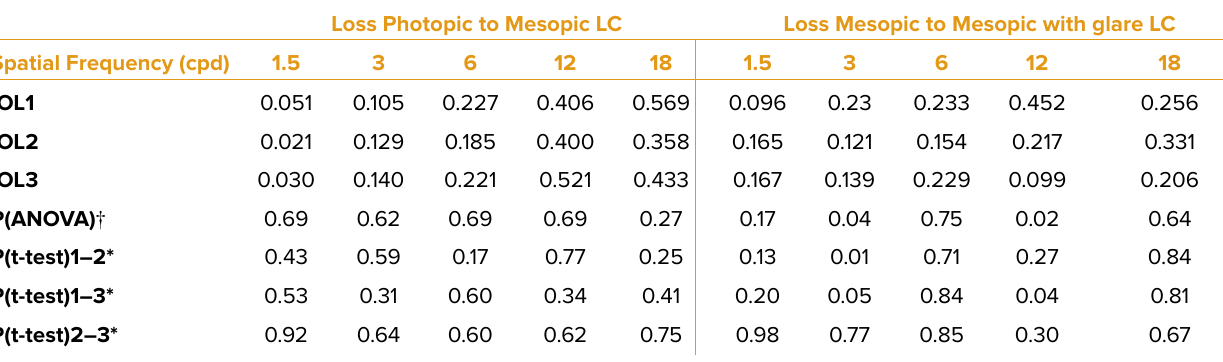
Table 4. Mean loss of contrast sensitivity, expressed in logarithmic units, from photopic to mesopic lighting conditions (LC) and under glare conditions in mesopic